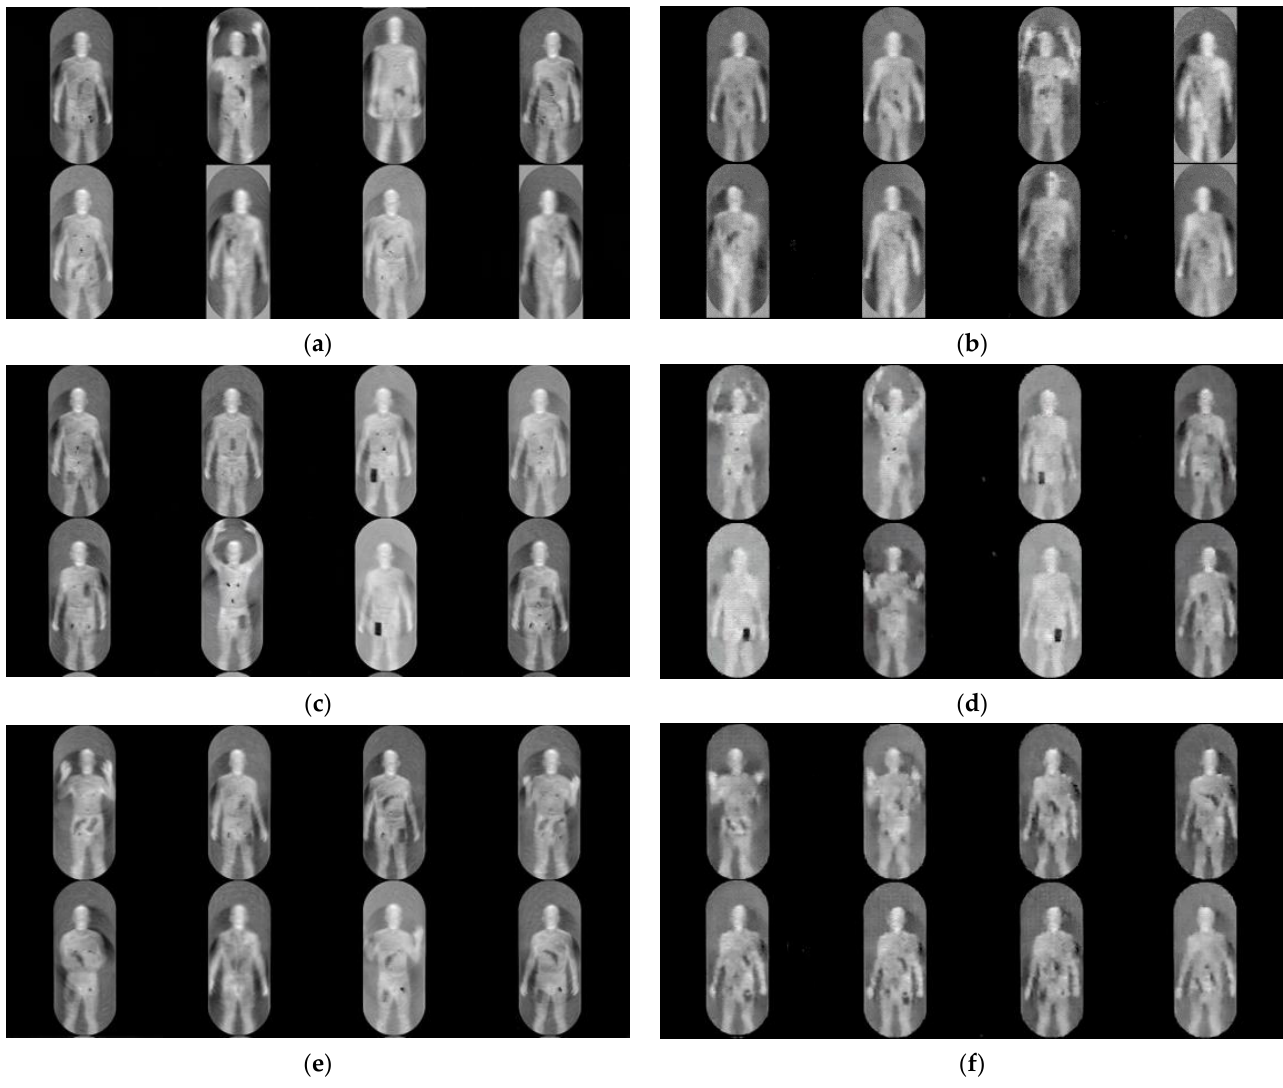
Figure 8. Three types of terahertz images generated by the two generators. ( a ) carrying a gun model generated by Res-WGAN-GP. ( b ) Carrying a gun model generated by WGAN-GP. ( c ) Carrying a cell phone generated by Res-WGAN-GP. ( d ) Carrying a cell phone generated by WGAN-GP. ( e ) Carrying two objects generated by Res-WGAN-GP. ( f ) Carrying two objects generated by